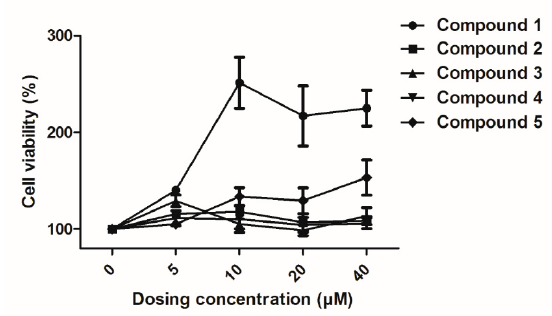
Figure 4. Effects of compounds 1 – 5 on the proliferation of human umbilical vein endothelial cells (HUVECs). HUVECs were cultured with different concentrations (0–40 µM) of compounds. Cellular proliferation was assessed using the Cell Counting Kit 8 (CCK-8) assay after 48 h. Data are expressed as the mean ± SEM ( n = 3) of three individual experiments.